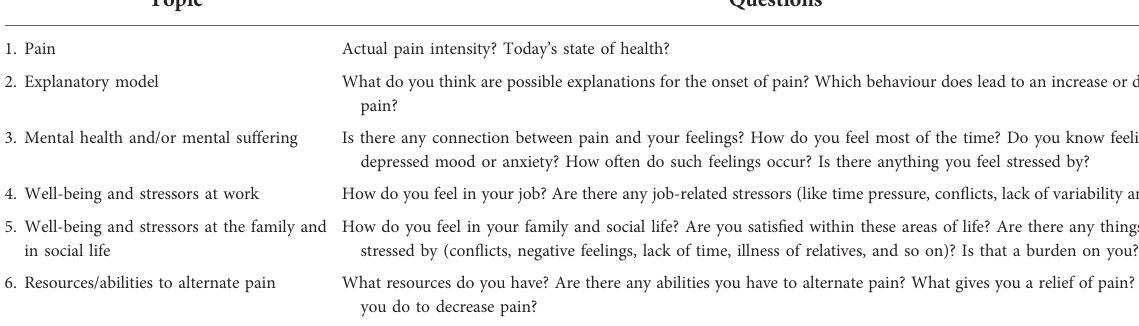
TABLE 1 Topics of half-standardized interviews.